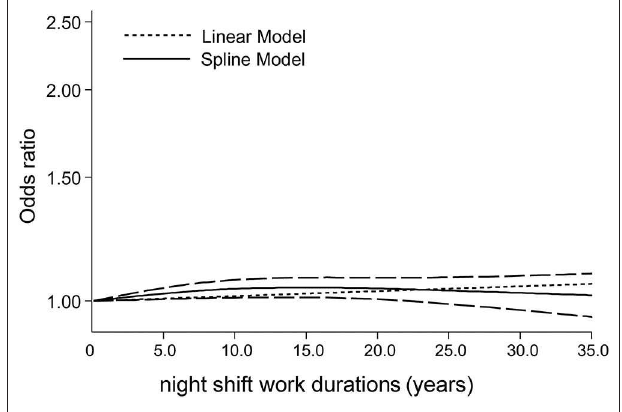
FIGURE 3 | Dose-response analysis on night-shift work durations and cancer risk.